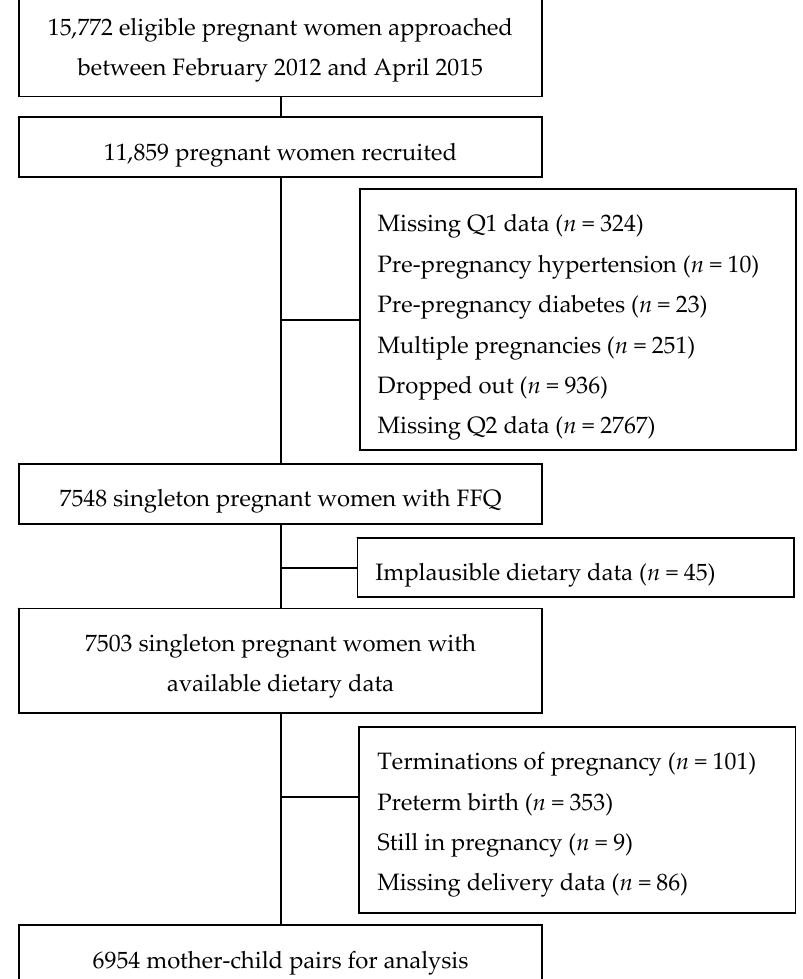
Figure 1. Selection process of study population in the Born in Guangzhou Cohort Study (BIGCS). FFQ refers to food frequency questionnaire.